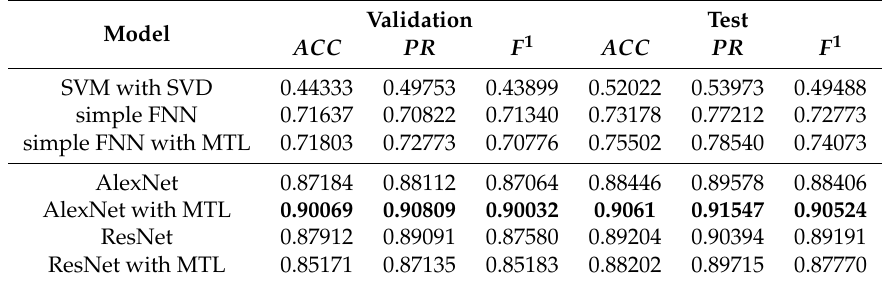
Table 2. The classification result of the tasks with different